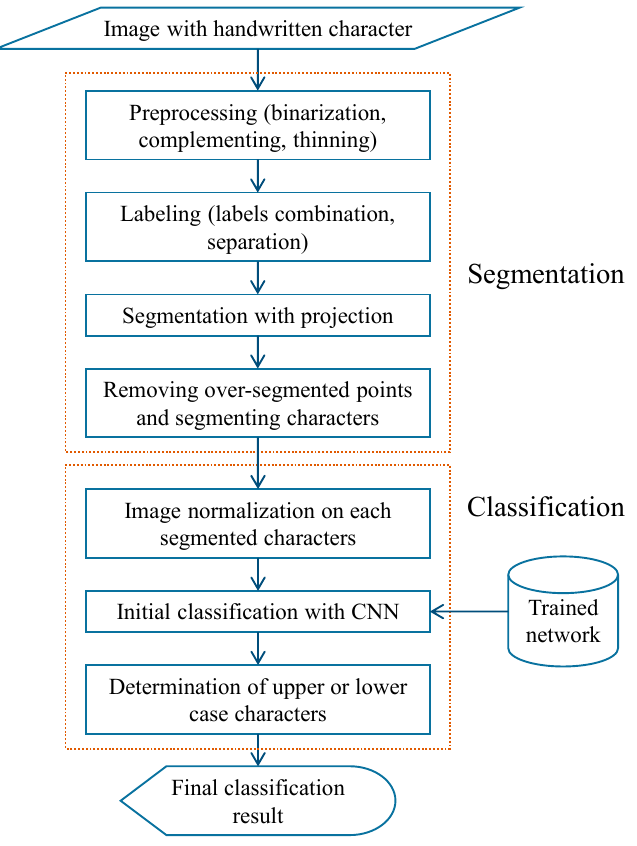
Figure 2. Flowchart of the proposed system.